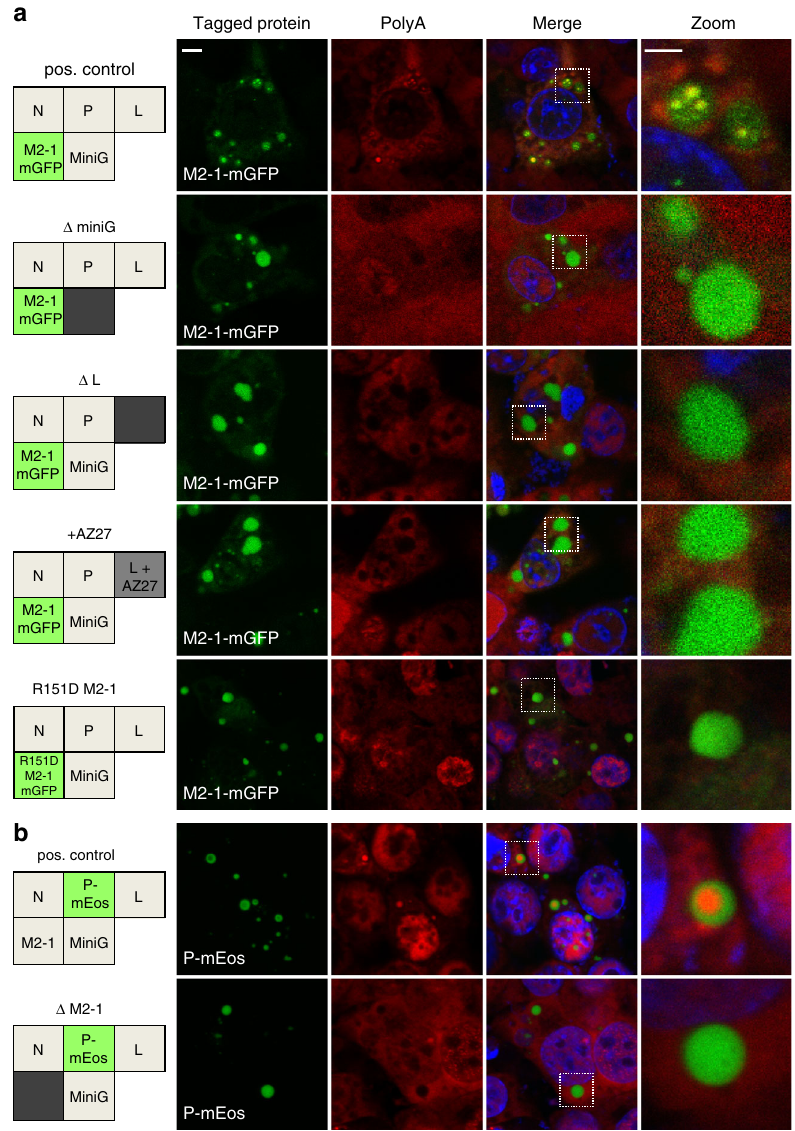
Fig. 6 Effect of viral RNA synthesis inhibition on IBAGs formation. BSRT7/5 cells were transfected with plasmids encoding the N, P, L and M2-1 proteins and the M/Luc subgenomic minireplicon. M2-1 mGFP a or PmEos b protein was expressed instead of the corresponding wild-type protein as indicated in the boxes on the left panel . a Plasmids encoding the subgenomic minireplicon ( Δ miniG) or the L protein ( Δ L) were omitted, or a polymerase inhibitor (+AZ27) was added, or wild-type M2-1mGFP was replaced by the R151D M2-1mGFP (impaired in RNA binding) as indicated by a gray box on the left panel . b Plasmid encoding the M2-1 protein was omitted ( Δ M2-1) as indicated by a gray box on the left panel . Poly(A) RNAs (red ) were detected by FISH analyses and cells were stained with an anti-N antibody ( gray ) and Hoechst 33258 (merge). The expressed tagged proteins, visualized by epi fl uorescence ( green ), are indicated in the box on the left panel and on the pictures. Representative images were taken under a Leica SP8 confocal microscope, scale bar 5 µ m. The boxed areas enclose IBs that are shown magni fi ed in the fourth column, scale bar 2 µ